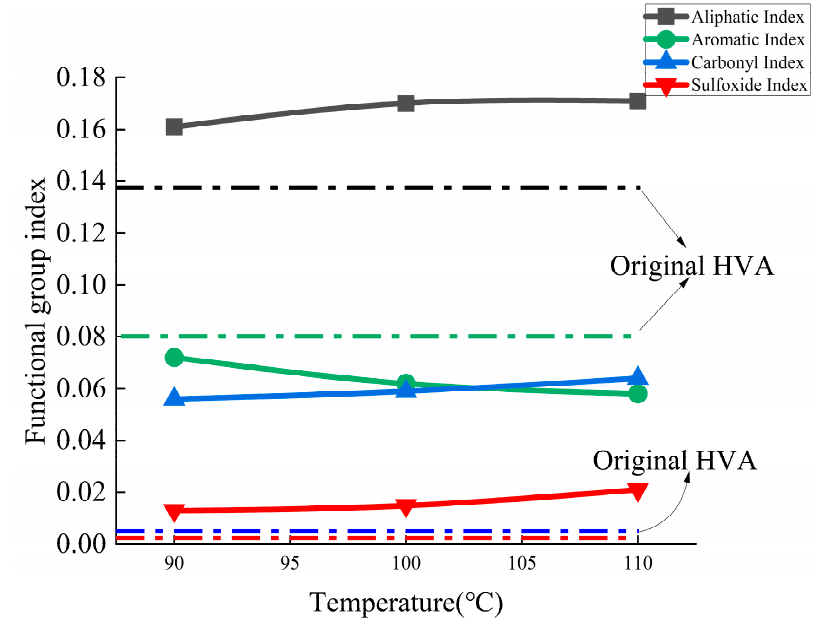
Figure 6. Change of functional group index under different temperature levels.